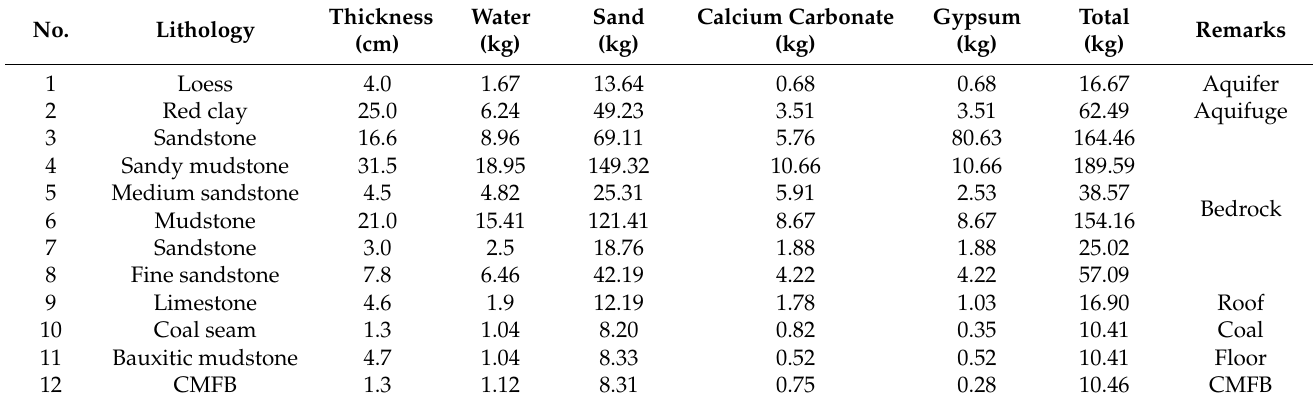
Table 2. The material ratios of strata and CMFB in the physical analogue model.